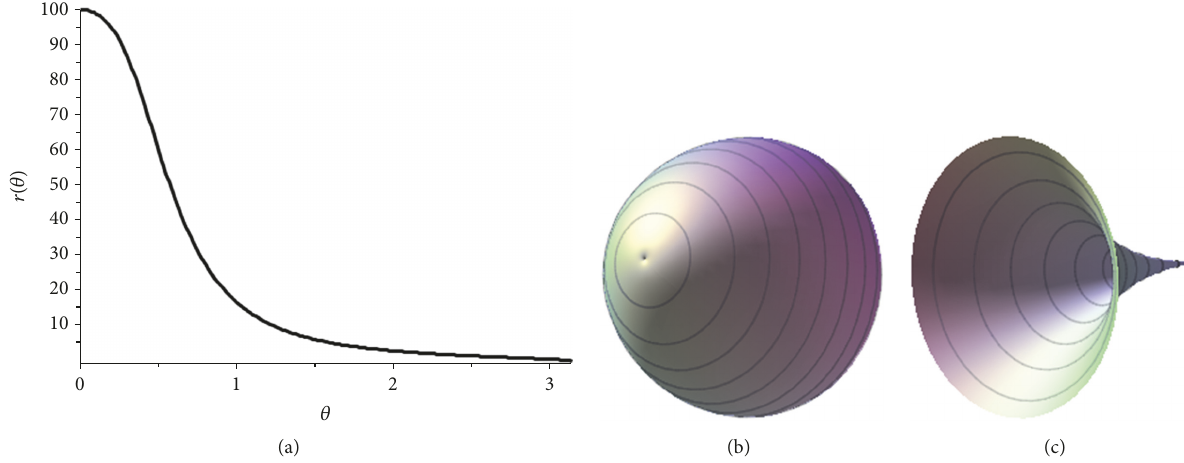
Figure 1: (a) Radius 𝑟(𝜃) of extra space for the parameter values 𝑎 = −100 , 𝑐 = −2.1 ⋅ 10 −3 and additional conditions 𝑟(𝜋) = 100 , 𝑅(𝜋) = 1.0251 ⋅ 10 −3 . (b) 3D plot of the solution. (c) A small part of the 3D plot near 𝜃 = 0 (left